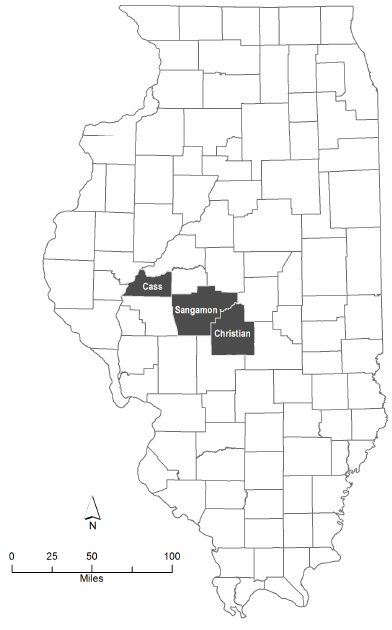
Figure 1. Map showing the location of the three Illinois counties in the study area.